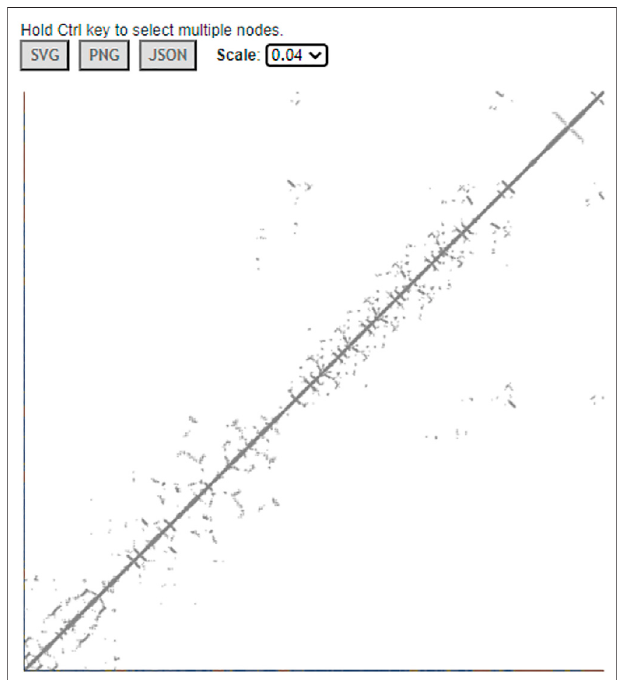
FIGURE 8 | Contact map of AlphaFold structure with UniProt ID A0A061AD48. The distance threshold is 8 Å between C-beta atoms. The sharable link is https://structure.ncbi.nlm.nih.gov/icn3d/share.html?